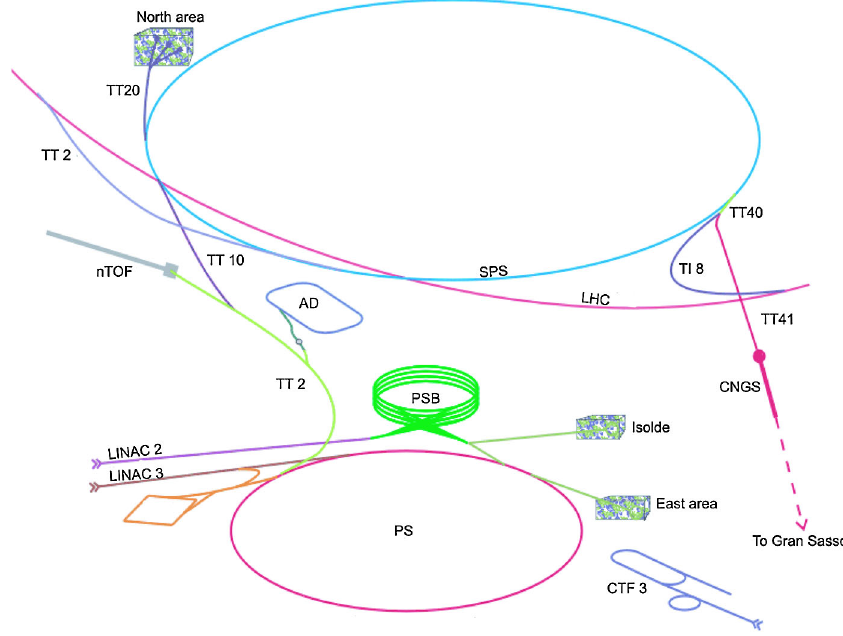
FIG. 2. (Color) Schematic view of the LHC preinjector